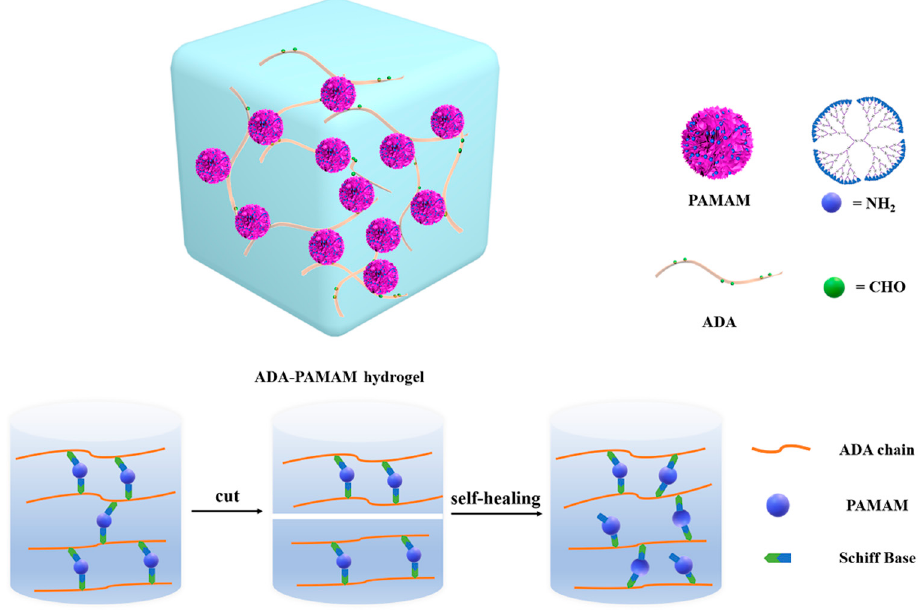
Figure 1. Diagram of ADA-PAMAM.